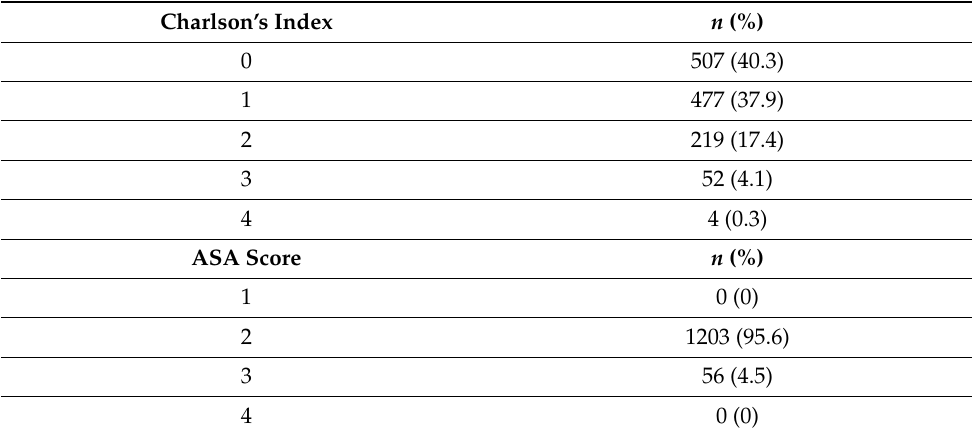
Table 2. Charlson’s Comorbidity Index and ASA score.